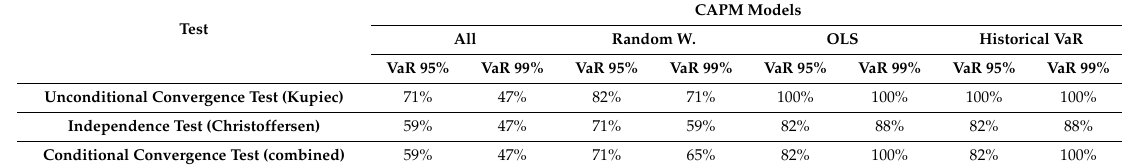
Table 7. Backtesting